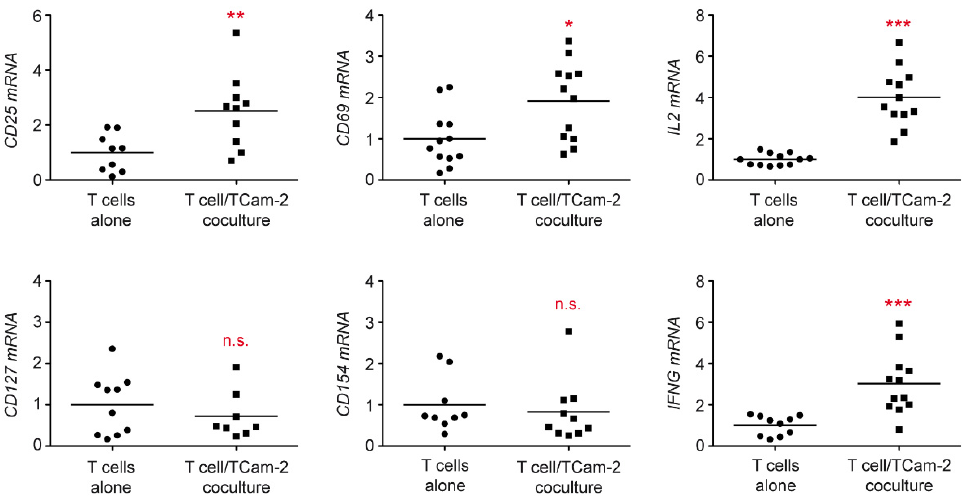
Figure 2. Gene expression analysis of peripheral blood T cells cocultured with TCam-2 cells by quantitative RT-QPCR. T cells were isolated from PBMC of healthy blood donors using magnetic cell sorting and cultured in 6-well plates either on a monolayer of TCam-2 cells or alone for 24 h. T-cells were collected from both cultures and RNA was prepared for subsequent analysis by quantitative RT-PCR. Relative mRNA expression levels of CD25 , CD127 , CD69 , CD154 , IL2, and IFNG are depicted as dot plots with a horizontal line representing the mean. Gene expression was calculated by normalization to the housekeeping gene 18SRNA , mRNA levels in T cells cultured alone were arbitrarily set to 1. N = 8–12; PBMC were obtained from 5–6 healthy volunteers. Statistical analysis was performed by unpaired t -test (*: p < 0.05; **: p < 0.01; ***: p < 0.001; n.s.: p >